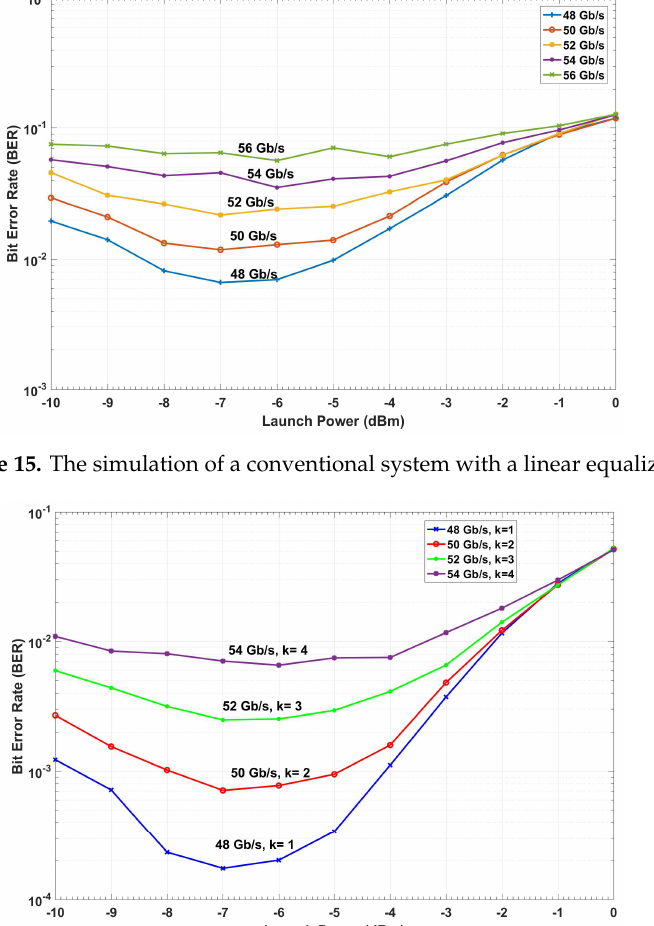
Figure 16. The simulation of a fiber optic system with CDS with the known model (BER improvement mode).